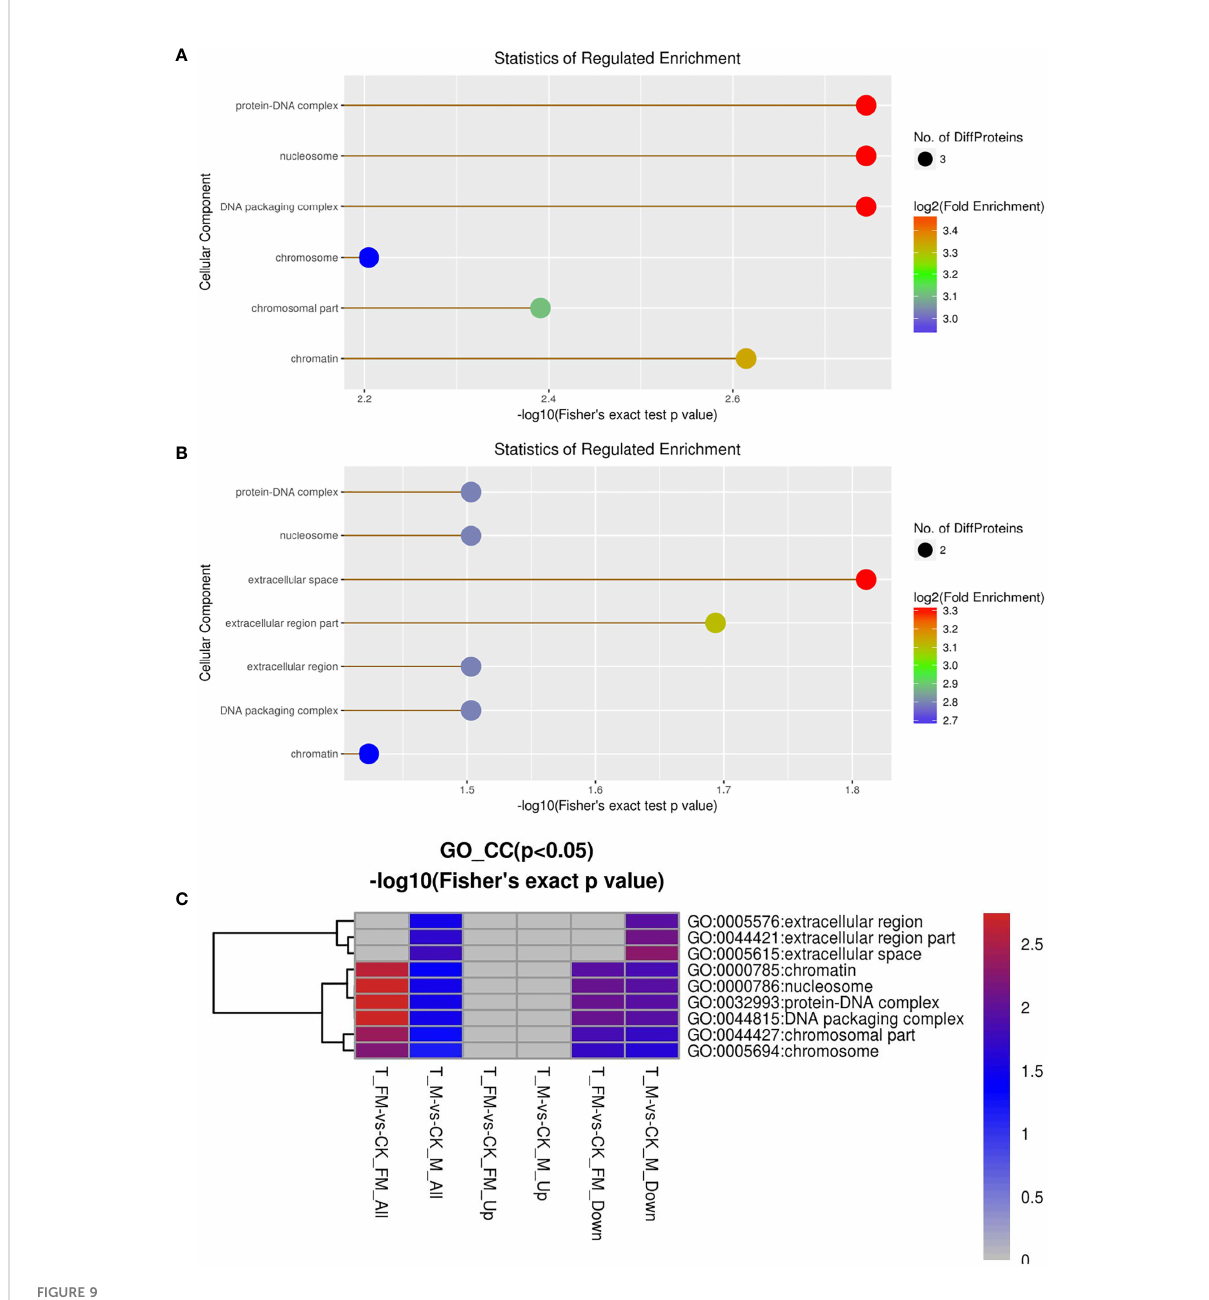
FIGURE 9 GO enrichment analysis for cellular component in female (A) and male (B) adult S. japonicum